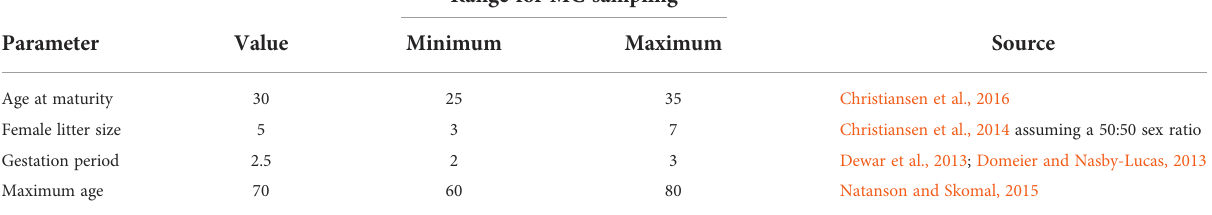
TABLE 1 Population vital rates used in the life table analyses to calculate the intrinsic rate of population growth (r) for South African white shark.